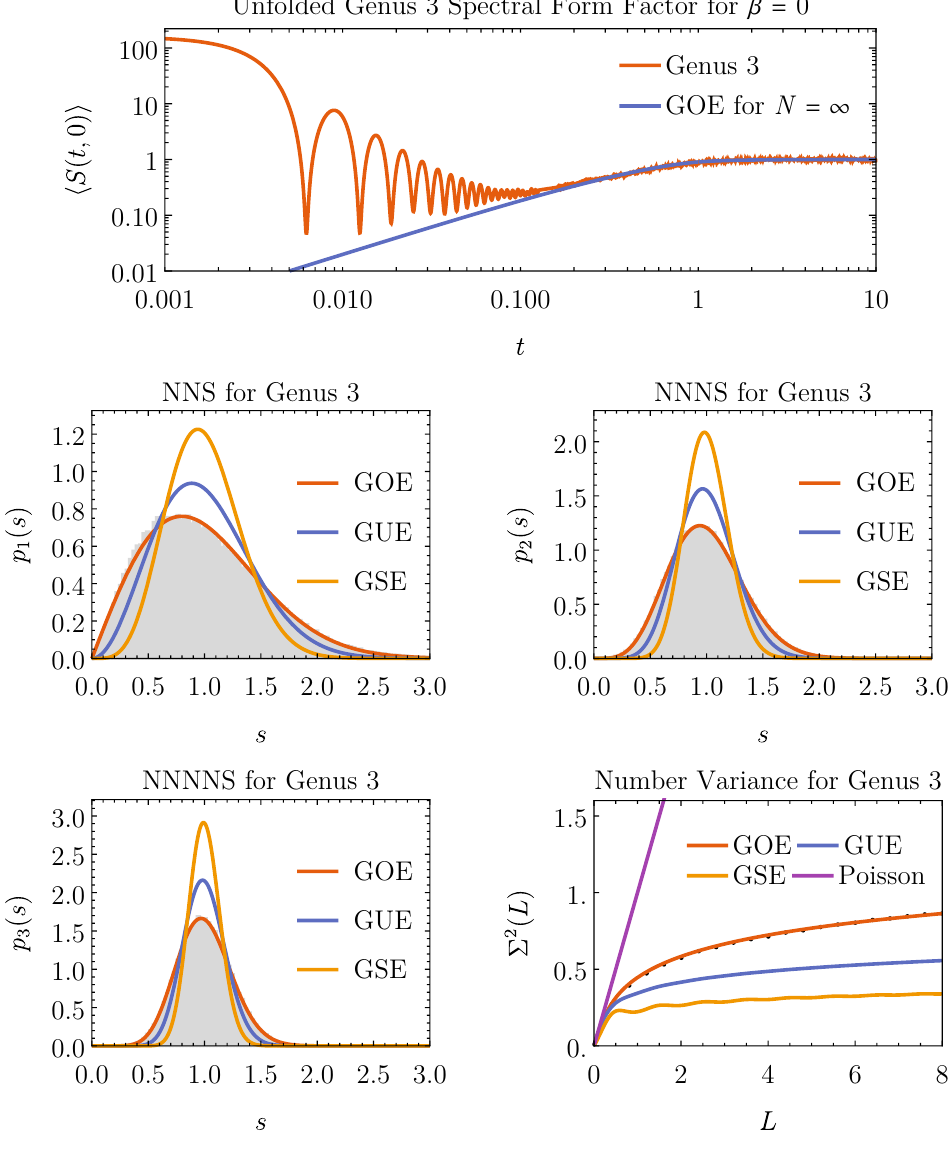
Figure 4 . The top row shows the unfolded spectral form factor for β = 0 for genus-3 curves. The orange curve shows an ensemble average consisting of 1,000 samples in complex structure moduli space with each sample containing the lowest-lying 160 eigenvalues. The dip, ramp and plateau are all present. The second and third rows display certain spectral statistics together with fits to GOE. (Other matrix ensembles are also shown for comparison.) The second row shows the nearest-neighbor level spacings (NNS) and the next-to-nearest (NNNS). The third row shows the next-to-next-to-nearest (NNNNS) level spacings and the number